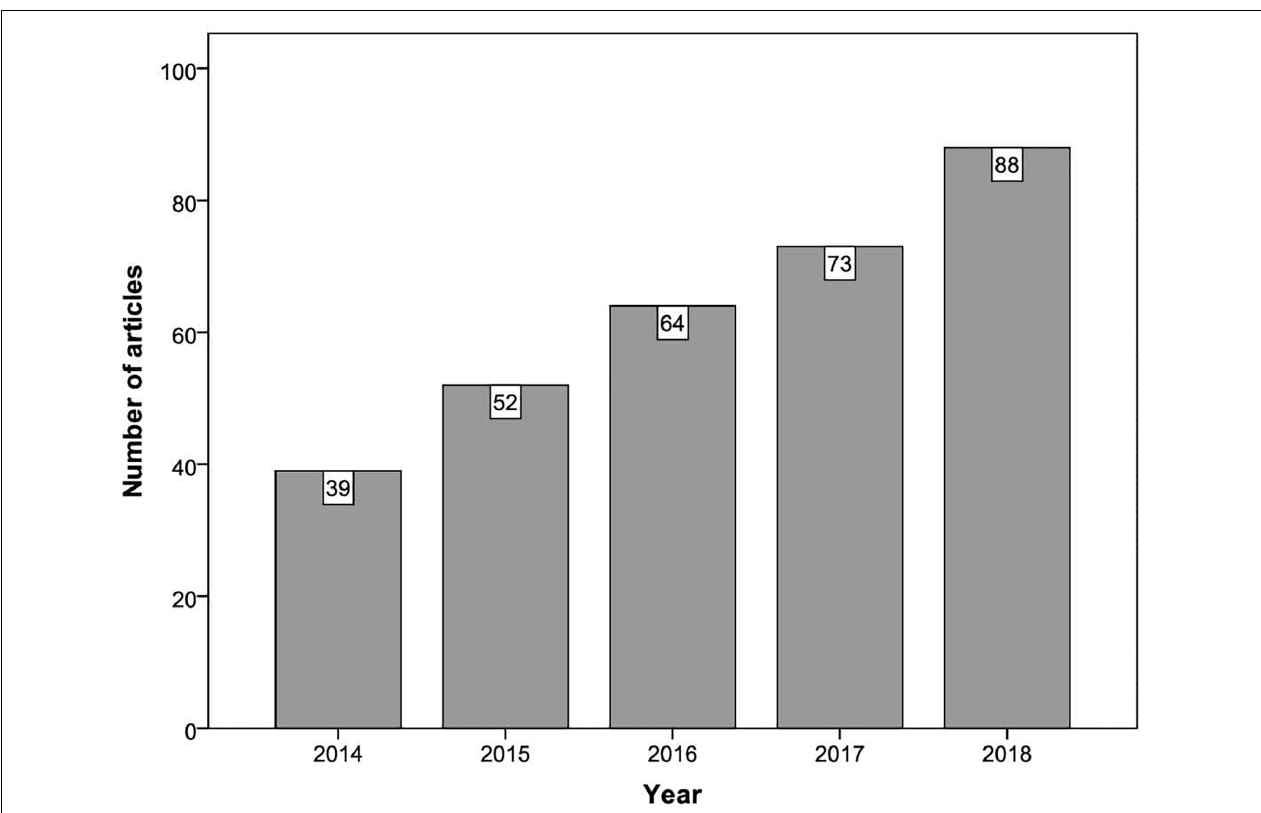
FIGURE 2 | Number of articles by publication